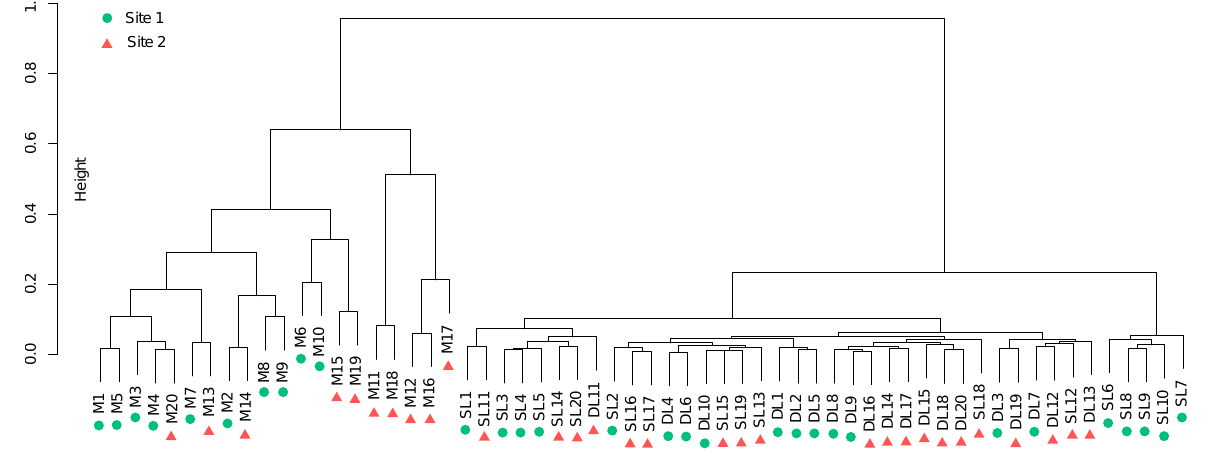
Fig. 5 Cluster dendrogram of the samples (mushrooms, surface soil layer, and deep soil) based on their macroelement content. Des- ignations of M1–20, SL1–20, and DL1–20 indicate the mushrooms (M), surface soil layer (SL), and deep soil samples (DL), respectively.